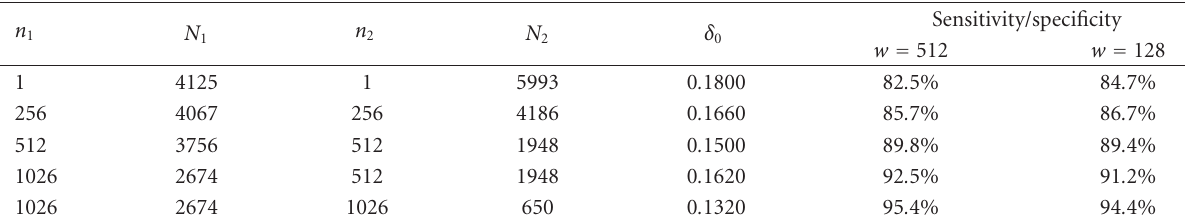
Table 1. Accuracy of the PFD-based coding-region identification algorithm on di ff erent coding/noncoding subsets. The parameters N N 1 and 2 are the numbers of coding and noncoding sequences with length greater than declared “coding” if MAXFD > δ 0 and “noncoding” otherwise. Accuracy is defined as the average of sensitivity and specificity. The threshold δ 0 is set at where sensitivity equals